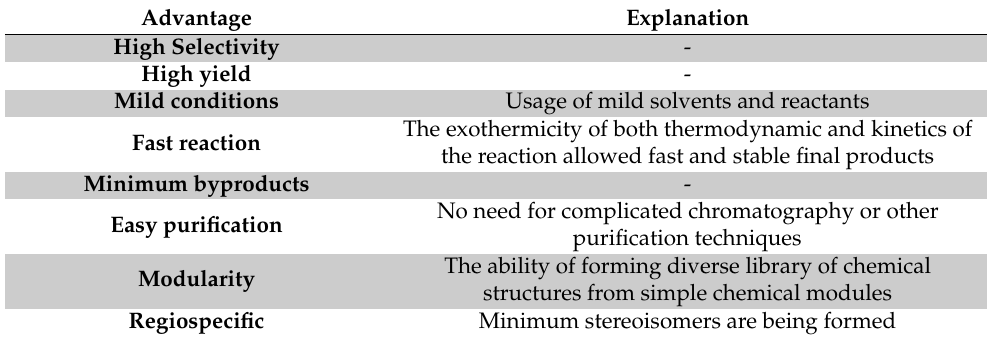
Table 1. Criteria for defining a certain reaction as a click